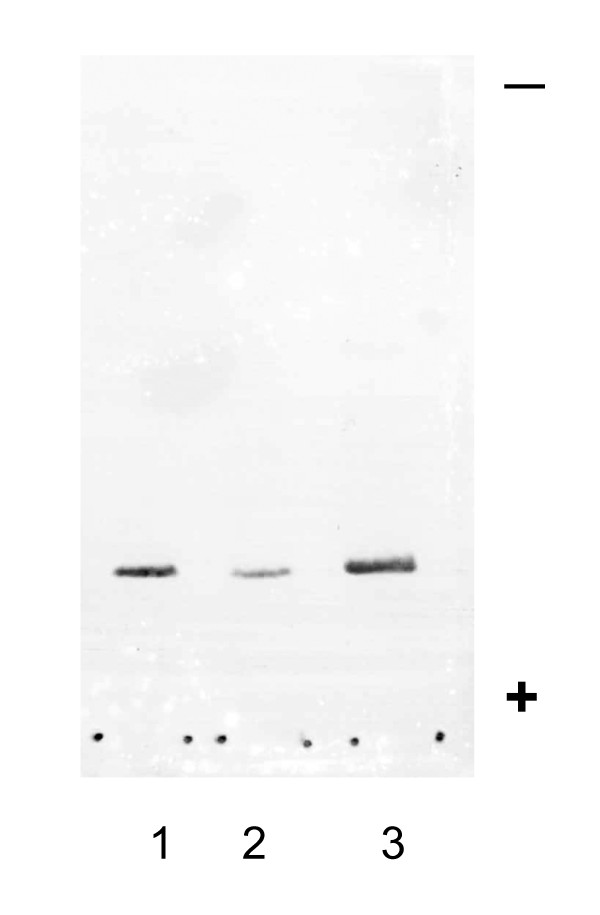
Western blotting after SDS-PAGE. A single band of CA-III from purified chicken CA-III (1), male WL-chicken hemolysate (2), and female WL-chicken hemolysate (3) is observed after staining by immunochemical method using anti-chicken CA-III serum. All bands had an approximate molecular weight of 28 kD. These data indicate that the antibody against chicken CA-III produced in the present study is specific to chicken CA-III.